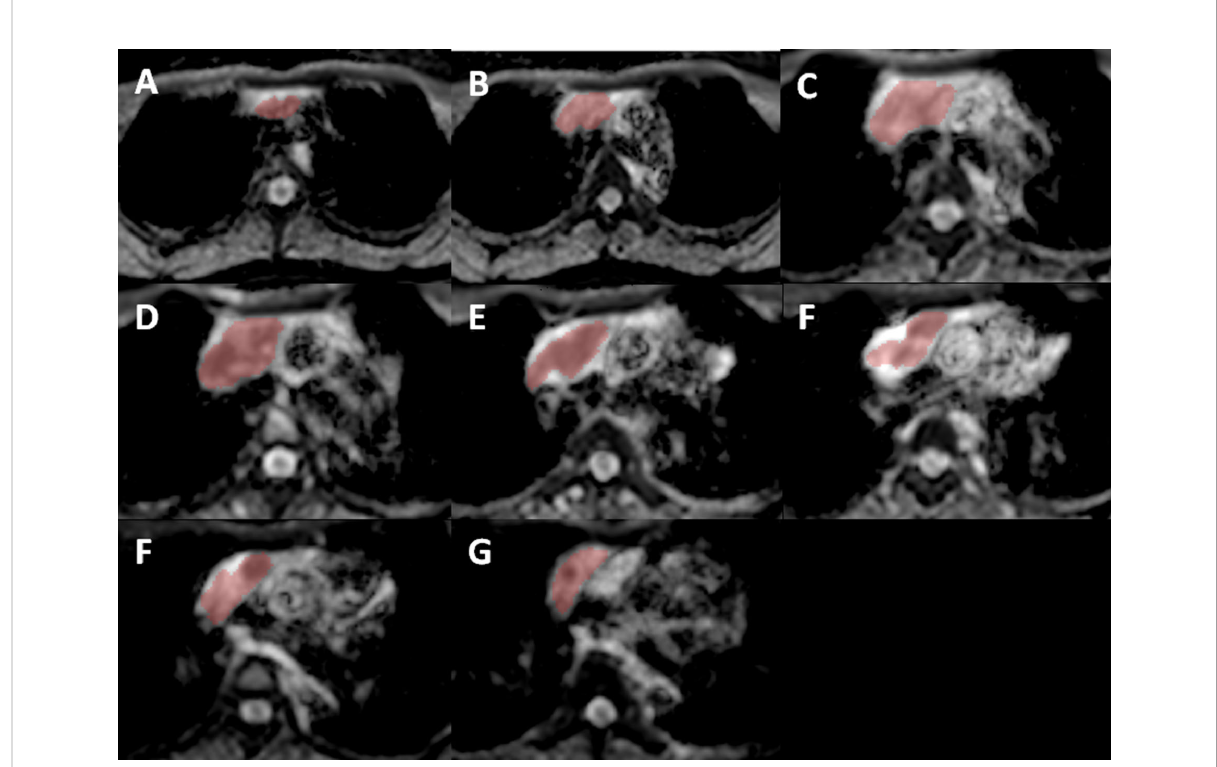
FIGURE 2 Using FireVoxel, ROIs were manually placed on consecutive slices of the ADC map across the whole lesion, from (A) being the most cephalic and (G) being the most caudal slice. Images from (B – F) are intermediate slices between these two following that